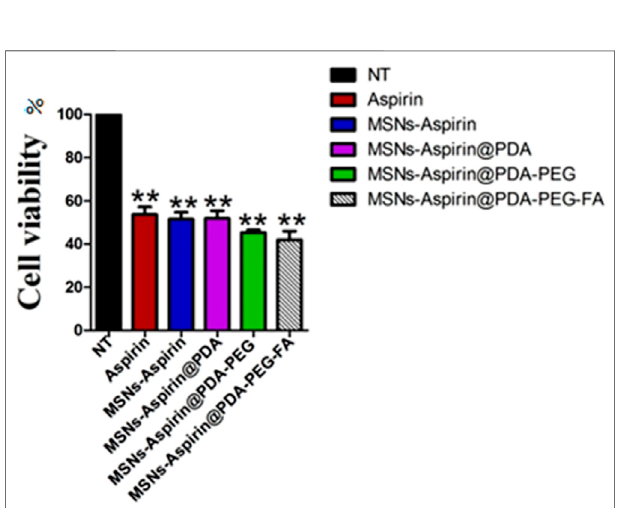
FIGURE3| MTTassaybased cellsviabilityofMCF-7 breastcancercells examined at 24 h; Cell culture is treated with Negative control (NT), free drug (Aspirin), drug-loaded in MSNs (MNP-Asp), and all other derivatives of Aspirin loaded MNPs prepared in this study (MNP-Asp@PD, MNP-Asp@PD- PG, and MSNs-Asp@PD-PG-F).